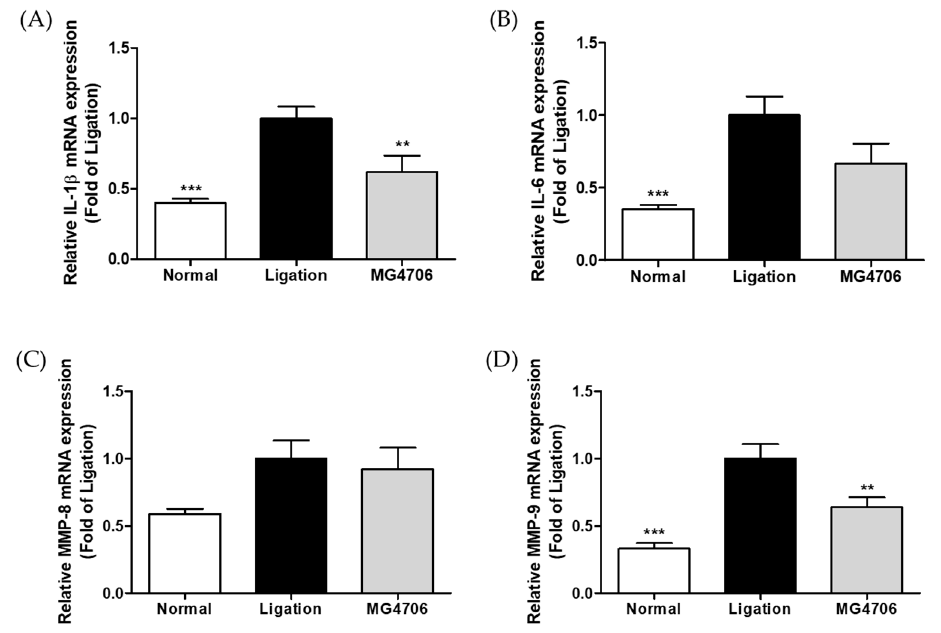
Figure 5. Effect of MG4706 on mRNA expression of ( A ) IL-1 β , ( B ) IL-6 , ( C ) MMP-8 , and ( D ) MMP-9 in gingival tissue for ligatured-induced periodontal rats. Data are represented as mean ± SEM ( n = 8). Significance was analyzed using Dunnett’s test. ** p < 0.01, *** p < 0.001 versus ligation group.